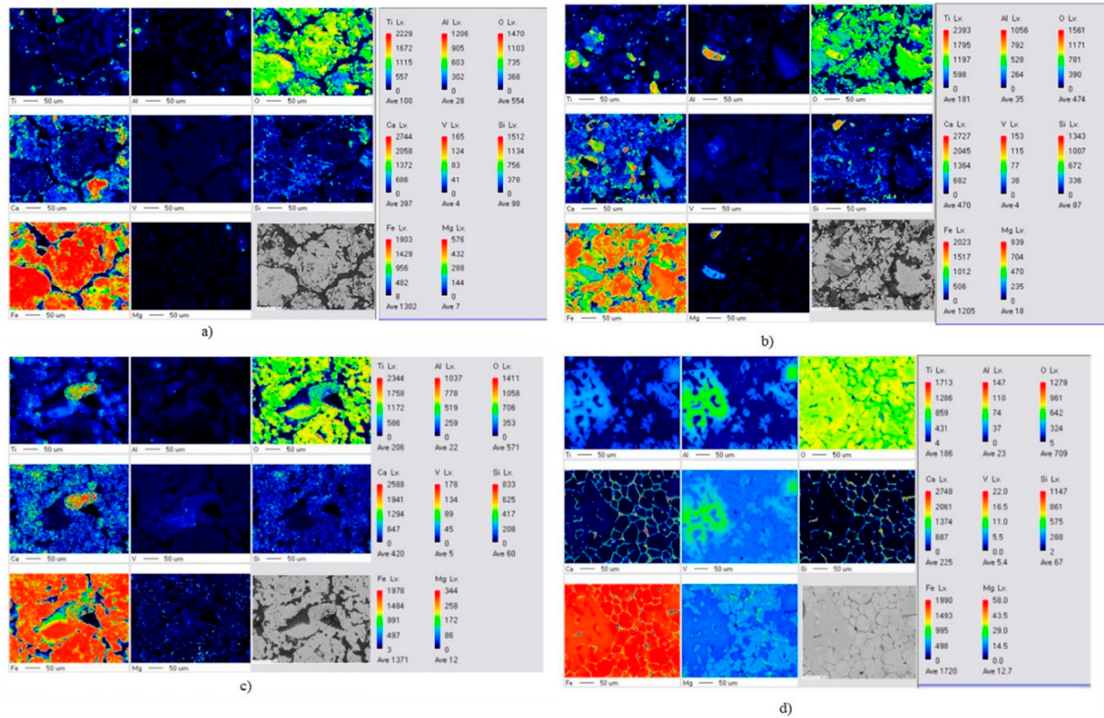
Figure 7. Elemental distribution analysis of sintered Blend 2 at ( a ) 1373 K; ( b ) 1423 K; ( c ) 1473 K; and ( d ) 1523 K .